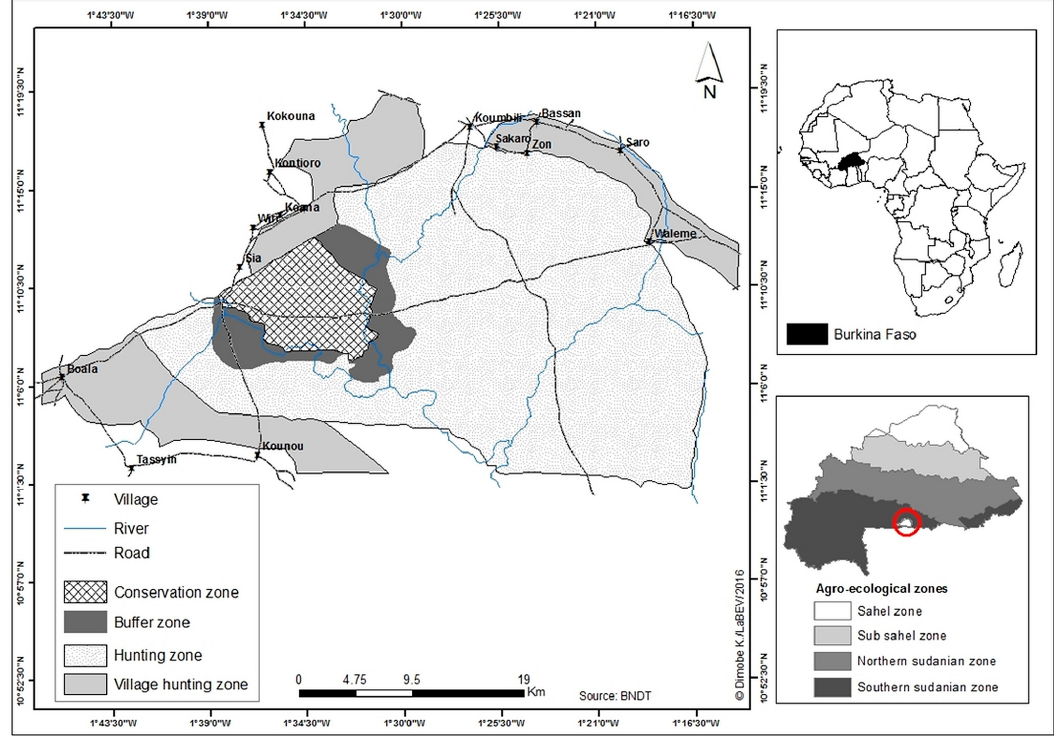
Figure 1. Nazinga Game Ranch, Burkina Faso.